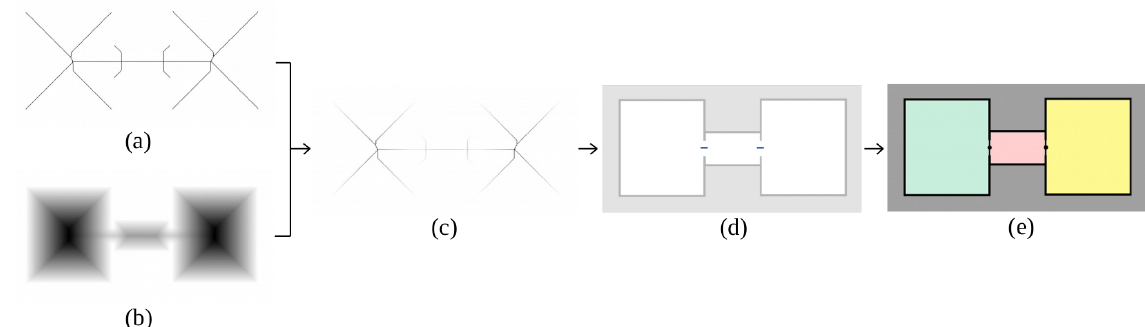
Figure 11. Geometric segmentation of occupancy grid maps using Voronoi diagrams: ( a ) skeleton, ( b ) distance transform, ( c ) combination of skeleton and distance transform, ( d ) selected segments ac- cording to standard door width, ( e ) segmentation results after including perpendicular line segments on every detected door.